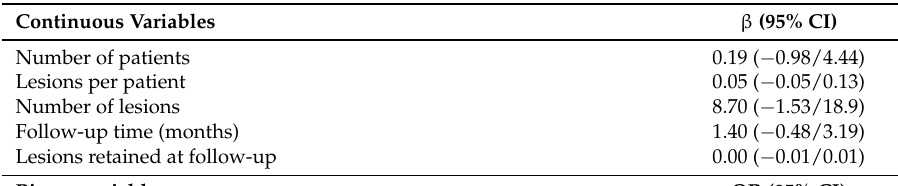
Table 2. Development of trial properties with